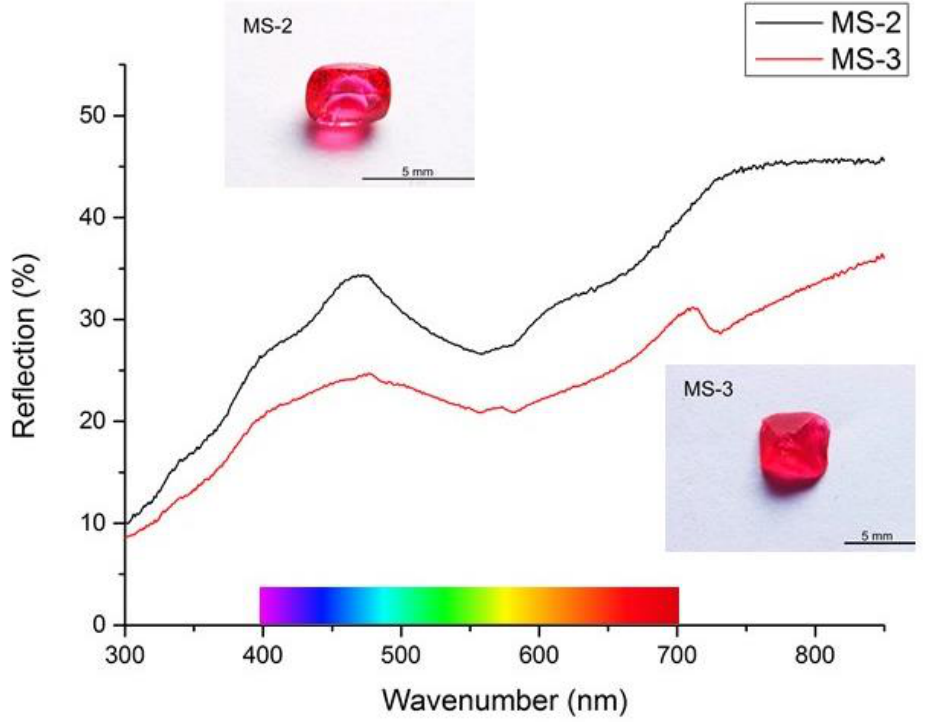
Figure 7. Effect of Zn on UV-Vis spectrophotometer .